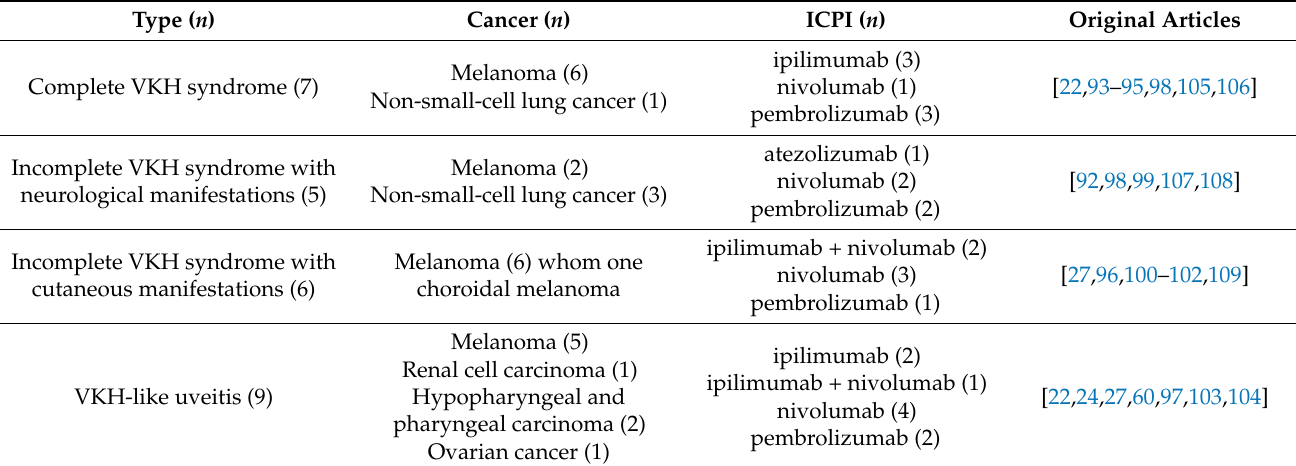
Table 8. VKH and VKH-like syndrome reported after the use of